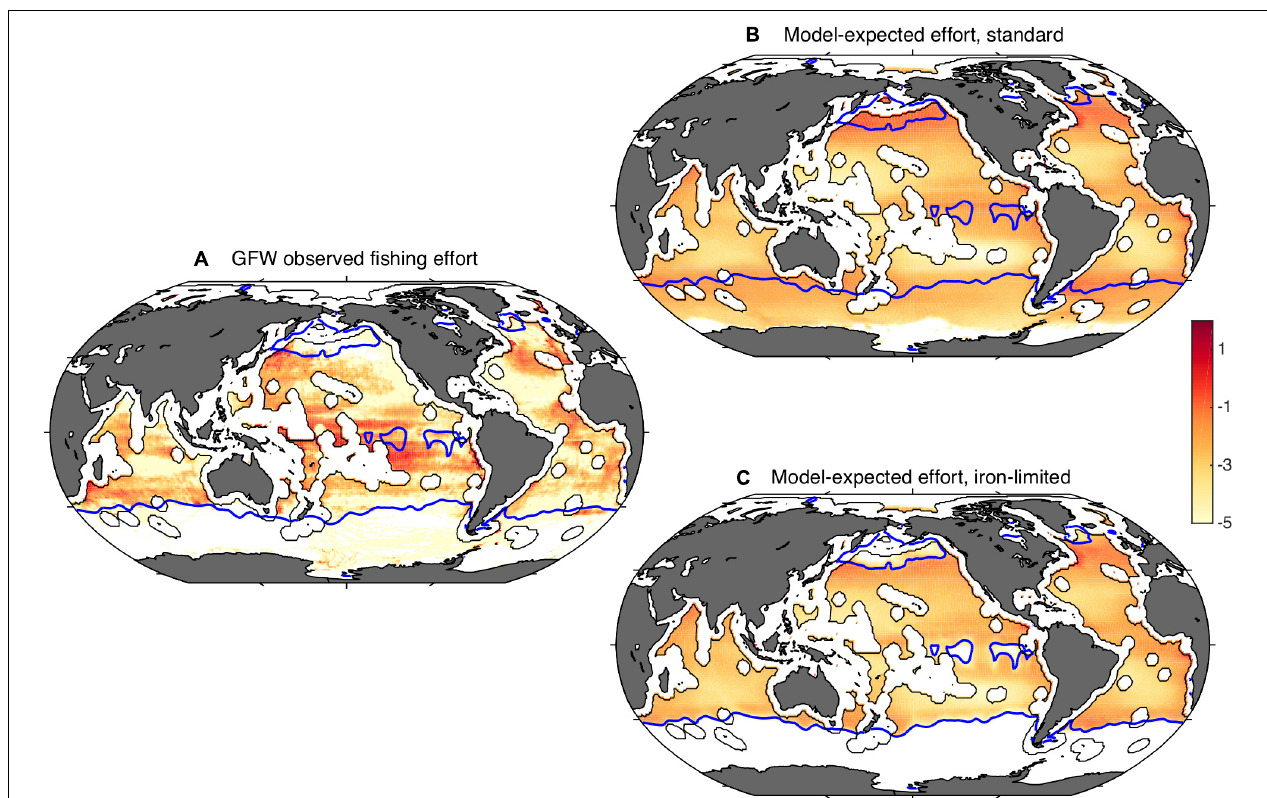
FIGURE 5 | Global fishing effort, observed and modeled. Panel (A) shows the total satellite-observed fishing effort of 2014 through 2016 as estimated by Global Fishing Watch (h km – 2 year – 1 ). The blue contours indicate HNLC regions, identified as waters with minimum monthly nitrate concentrations > 3 µ mol kg – 1 (Boyer, 2013). In general, high surface nitrate concentrations occur where strong iron limitation occurs. Panel (B) shows a bio-economic model expectation of fishing effort (W m – 2 ), based on the satellite-observed primary production and the climatological water temperature, and panel (C) shows the same model prediction including the iron-limitation of carbon trophic transfer efficiency described in the text. Efforts are plotted as natural logarithms. Exclusive Economic Zones are excluded.